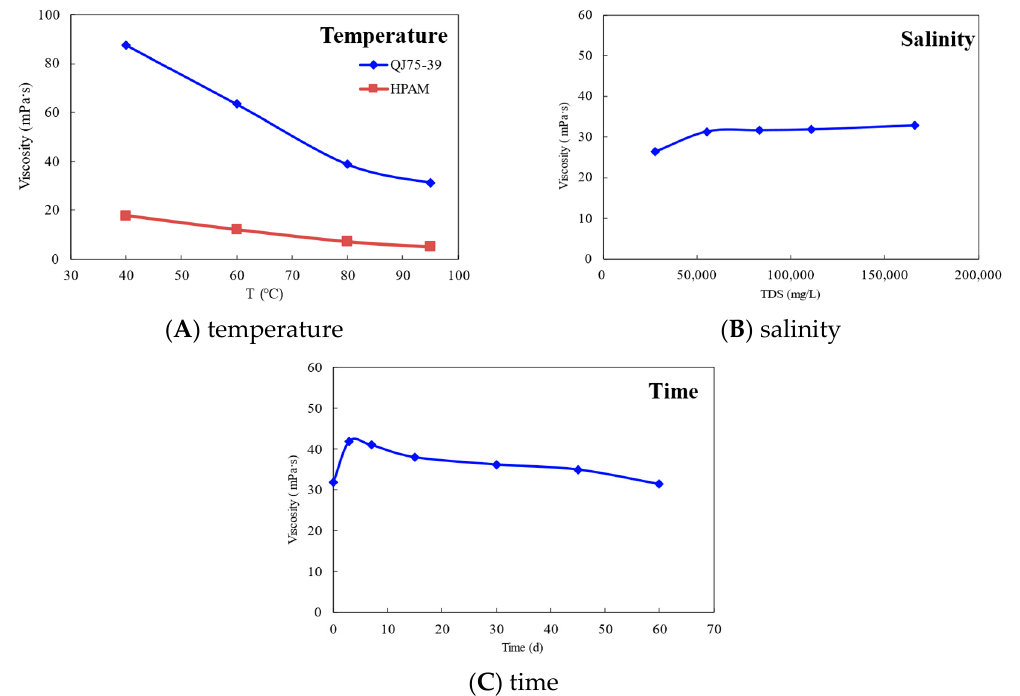
Figure 9. Influencing factors for the polymer.